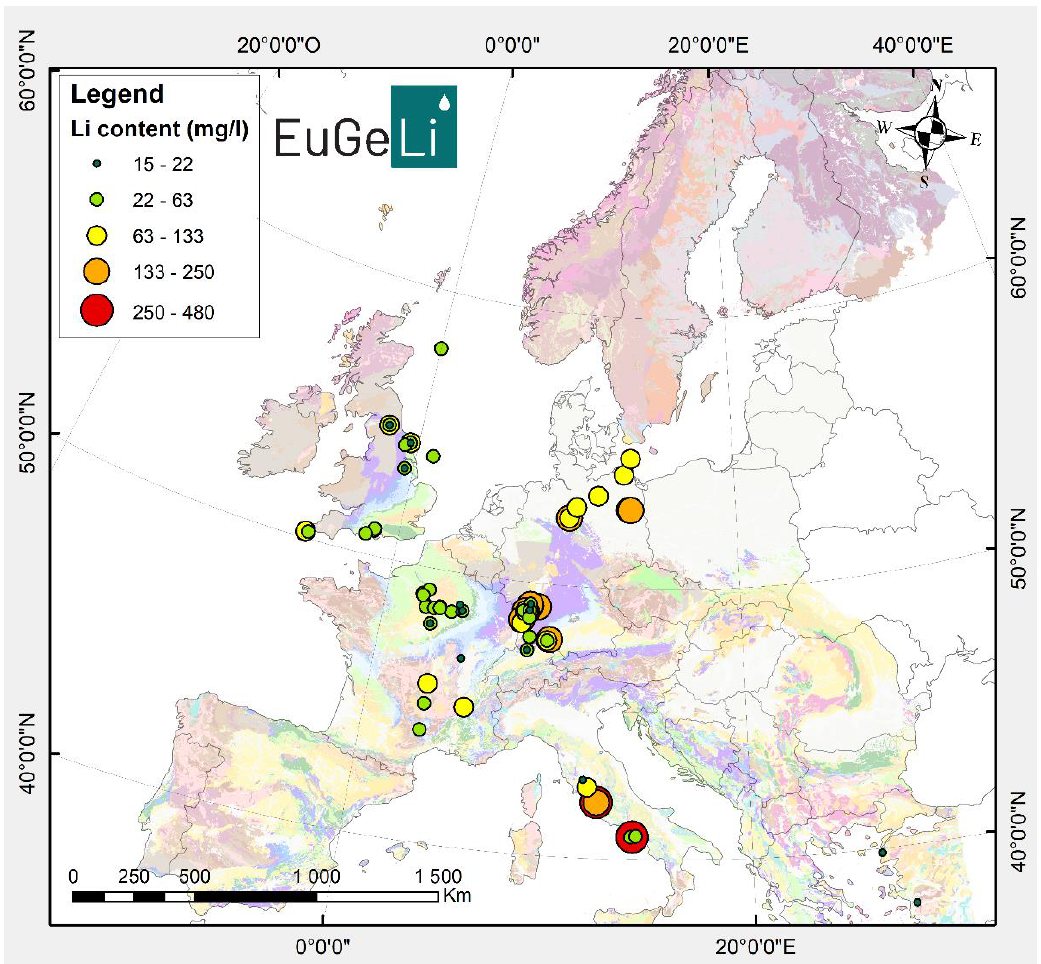
Figure 8. Distribution and abundance of Li in geothermal brines in Europe [46,48]. Significant geothermal lithium resources have been identified in Europe. Reproduced with the permission of the authors.